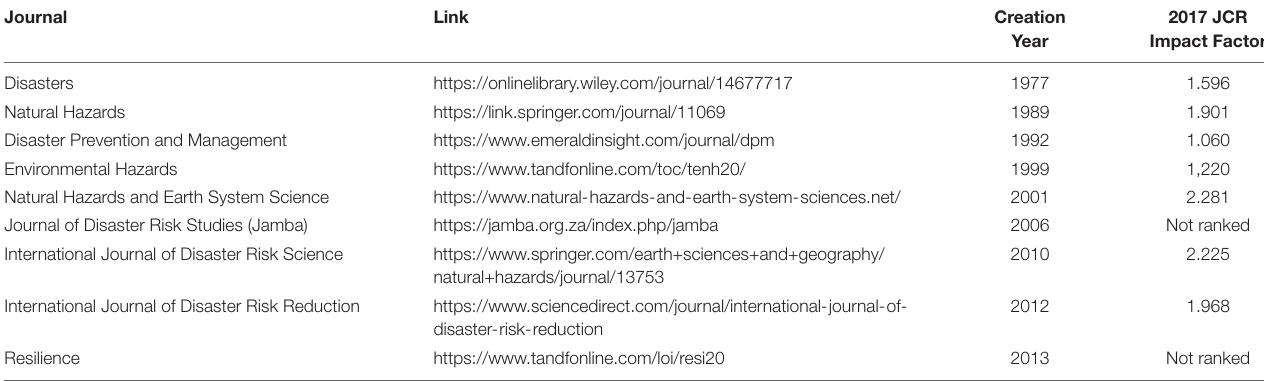
TABLE 3 | Selected journals for this literature review.